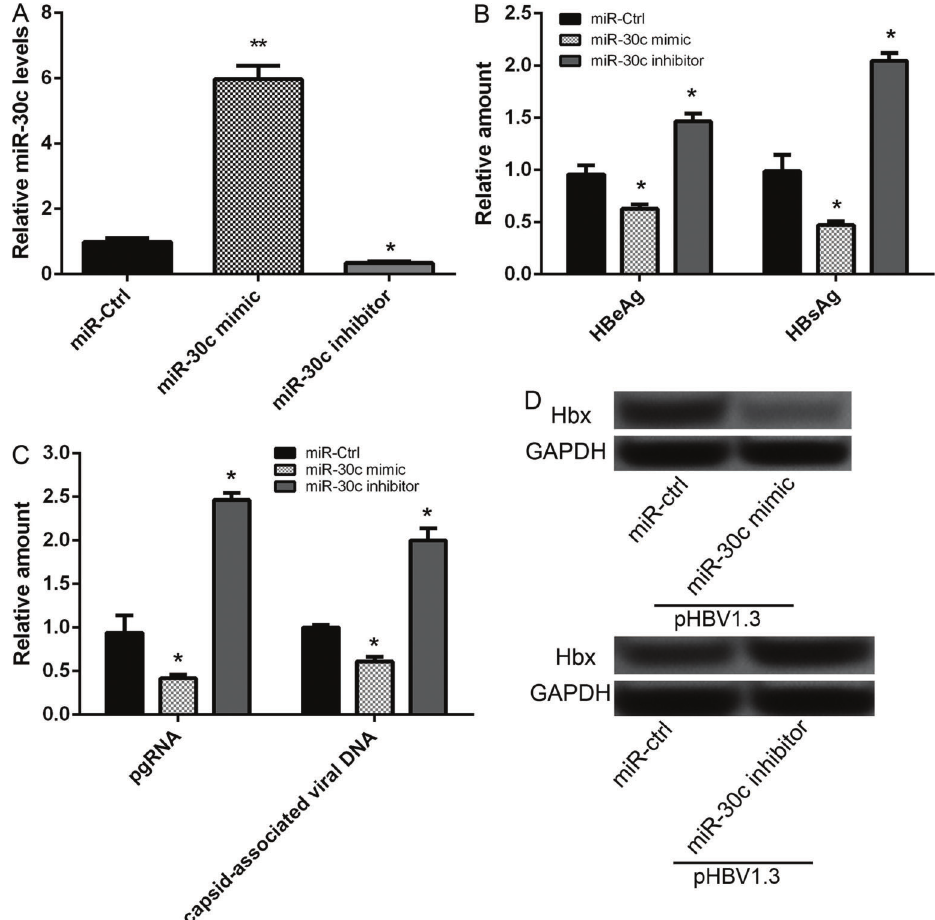
Figure 2. Overexpression of miR-30c inhibited HBV replication and gene expression in hepatoma cells. A , miR-30c expression in hepatoma cells after transfection with miR-30c mimic, inhibitor or scramble control. B , Amount of HBeAg and HBsAg in hepatoma cells after co-transfection with pHBV1.3 and 50 nM of miR-30c mimic, inhibitor or scramble control for 48 h. C , Expression levels of HBV pgRNA and capsid-associated virus DNA in hepatoma cells after co-transfection with pHBV1.3 and miR-30c mimic, inhibitor or scramble control for 72 h. D , Expression levels of Hbx protein in hepatoma cells after co-transfection with pHBV1.3 and miR-30c mimic, inhibitor or scramble control for 48 h. Data are reported as means ± SD. *P o 0.05, **P o 0.01 compared to scramble controls